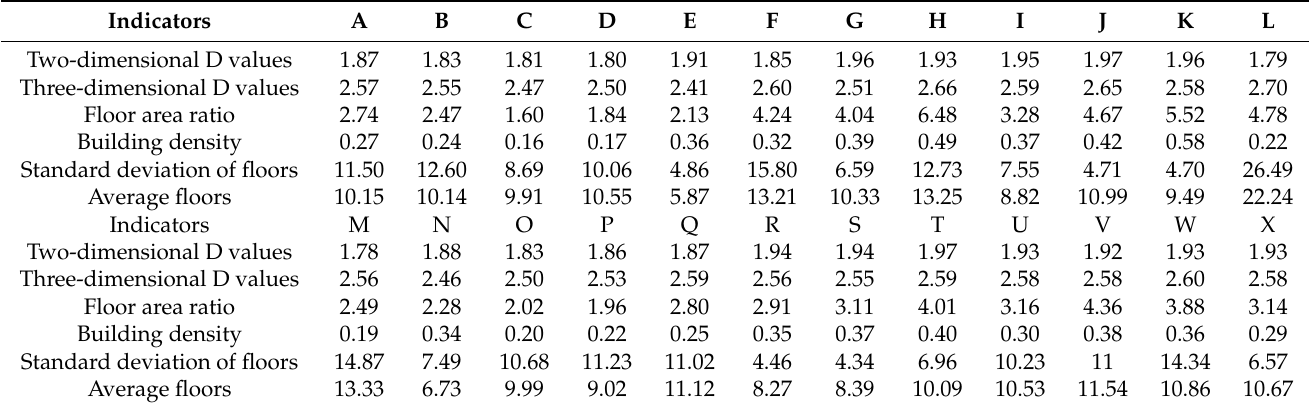
Table 5. Statistics of 2D and 3D fractal dimensions of